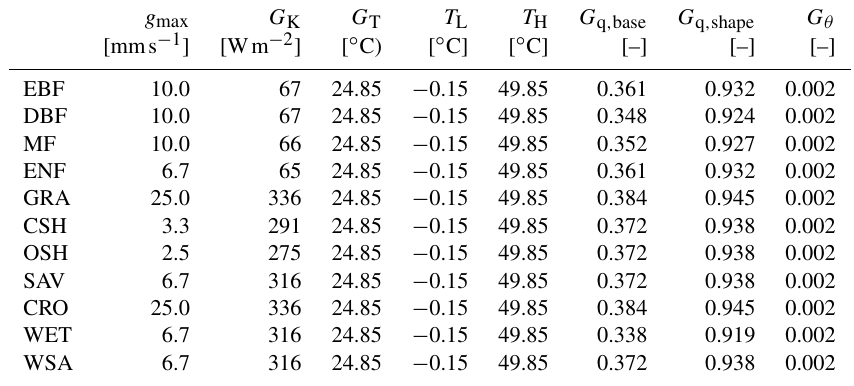
Table A1. NOAH-derived (data: based on Tables 1 and 2 of Chen and Duhdia, 2001) surface-conductance-related parameters for SUEWS.